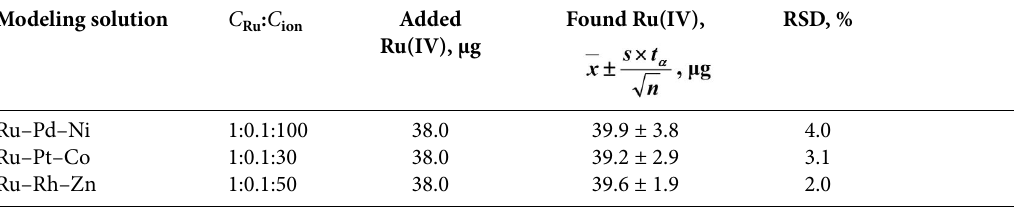
Table 4. Determination of ruthenium(IV) in alloys (n = 3; P =